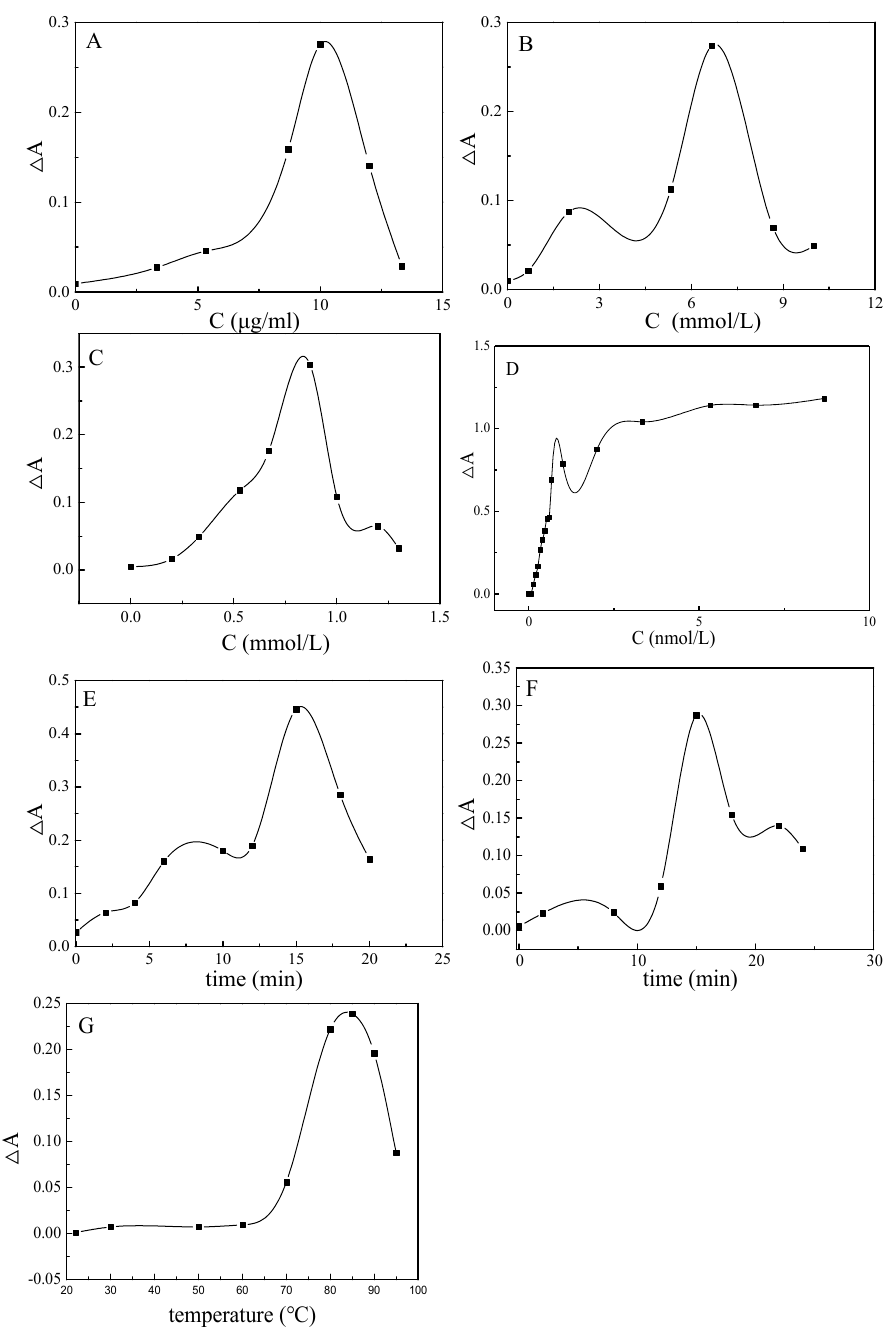
Figure 10. Condition optimization. ( A ): The effect of AgCOF concentration. ( B ): The effect of trisodium citrate concentration. ( C ): The effect of AgNO 3 concentration. ( D ): The effect of aptamer concentration. ( E ): The effect of standing time. ( F ): The effect of water bath time. ( G ): The effect of water bath temperature.